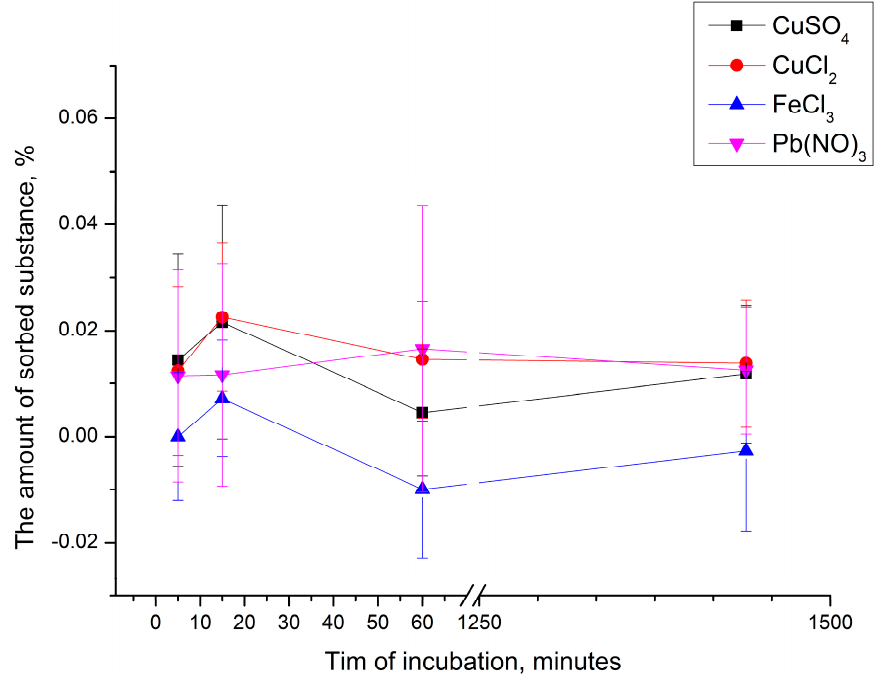
Figure 3. Change in the amount of sorbed of CuSO 4 , Pb(NO) 3, FeCl 3 , and CuCl 2 by PMC depending on the time of incubation. As can be seen from Figure 3, the amount of sorbed substance does not exceed 1% even after 24 h of incubation. Thus, we can conclude that polyelectrolyte microcapsules consisting of PSS and PAH are not suitable for the sorption of CuSO 4 , Pb(NO) 3, FeCl 3 , and CuCl 2 salts.